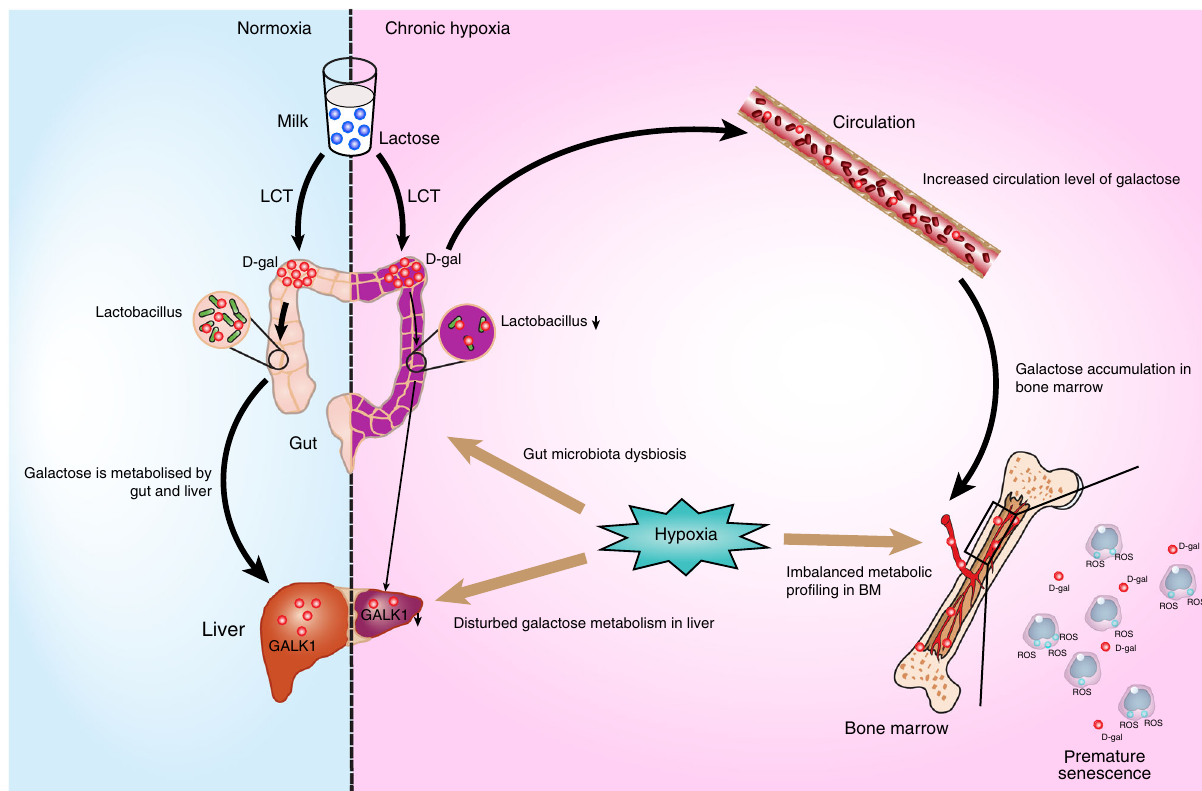
Fig. 7 Summary Figure. As a constituent of milk, lactose is the major nutrient for infants and young children. Chronic profound hypoxia induced by CCHD results in alterations in the diversity of gut microbial communities, with markedly decreased Lactobacillus and a reduction in enzymes that degrade D - galactose. Cumulative D -galactose in the blood and BM induced premature senescence of BMSCs through ROS